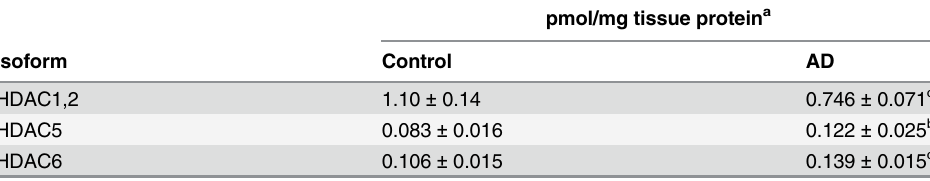
a Measurements were performed on supernatant of frontal cortex from age-matched control (n = 5) and severe AD (n = 5) human donor pools (S4 Table) supplemented with QconCAT standard after high-speed centrifugation. Concentrations were calculated for three biological replicates and with three transitions per Q-peptide. Q-peptide transitions are summarized in S6 Table. Data presented as mean ± SD. b , p < 0.01;